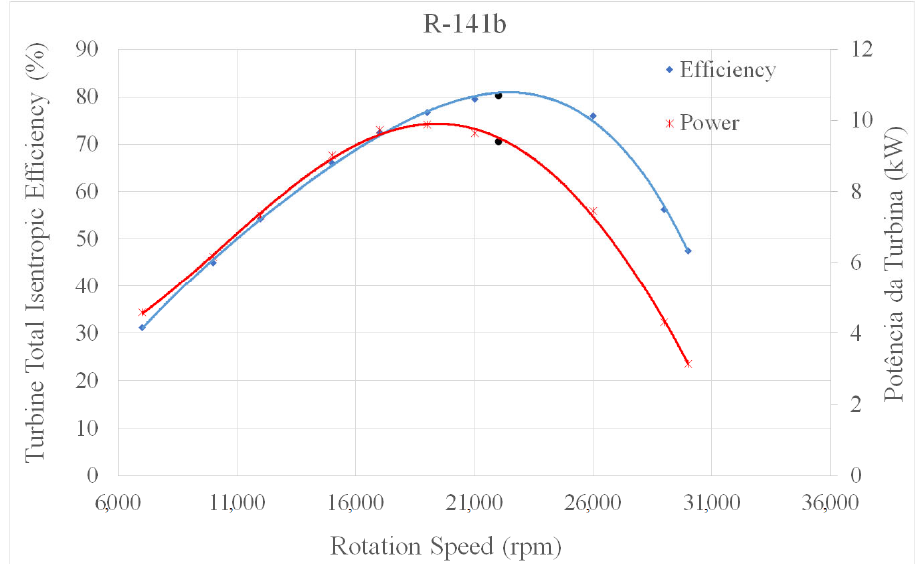
Figure 16. Variation in the total isentropic efficiency and power of the turbine operating with R-141b, as a function of rotation speed.